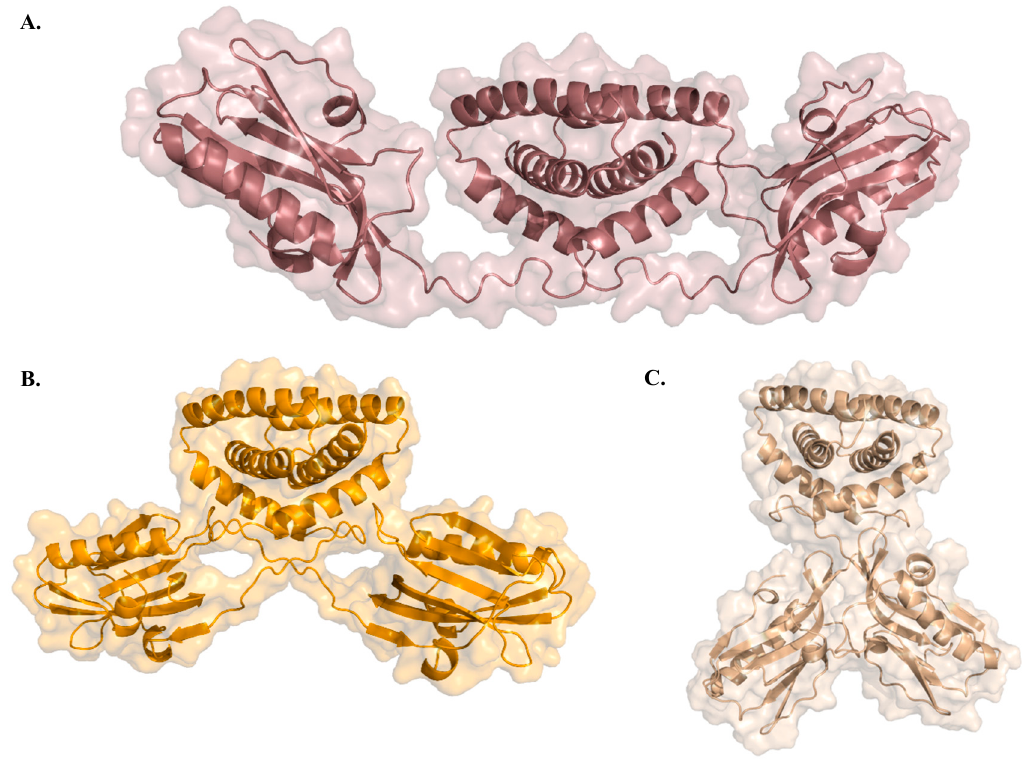
Figure 3. Three X-ray crystallography NS1 structures illustrating the different conformational arrangements of the NS1 dimer: ( A ) “Open” conformation (PDB ID: 6O01 [53]), ( B ) “semi-open” conformation (PDB ID: 4OPH [41]), and ( C ) “closed” conformation (PDB ID: 4OPA [41]).